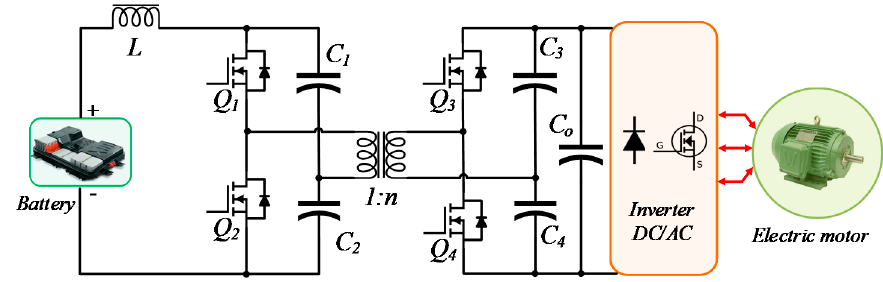
Figure 10. Isolated ZVS DC-DC Converter.